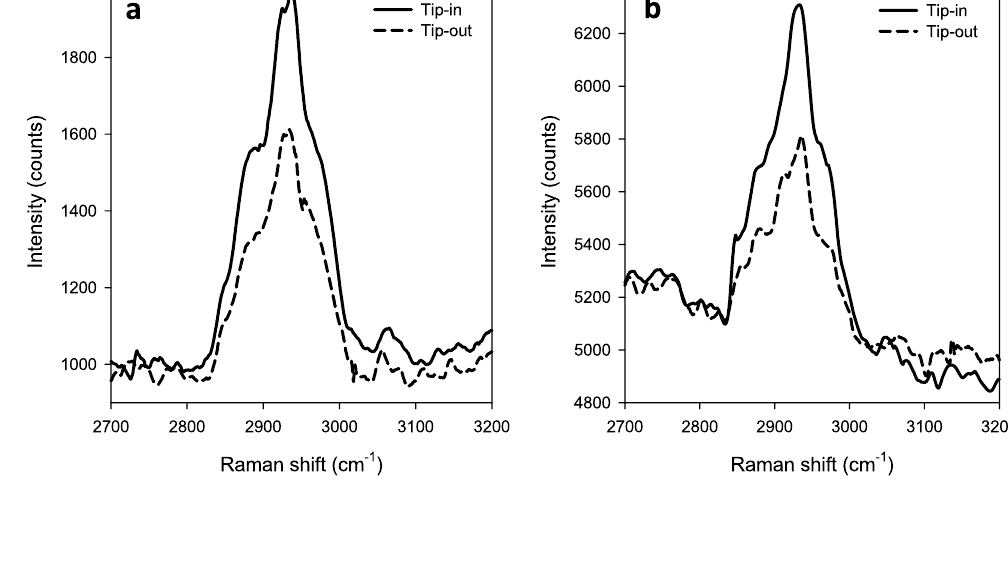
3 Scientific RepoRts | 7: 3810 | DOI:10.1038/s41598-017-02212-2